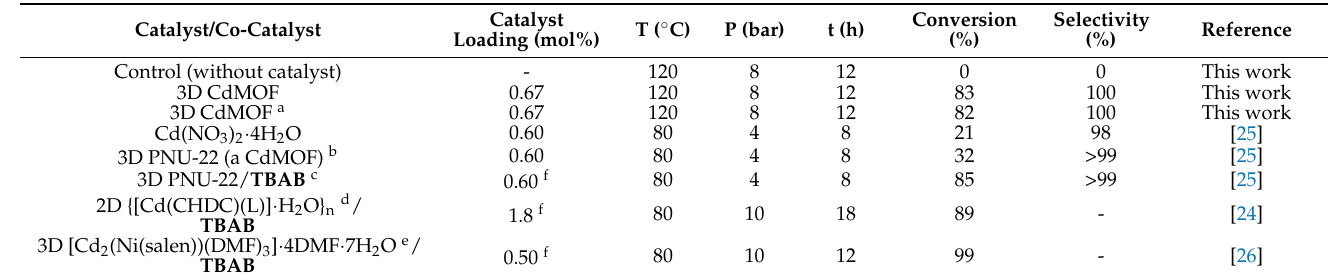
Table 1. Cycloaddition of CO 2 to epichlorohydrin catalyzed by CdMOF without cocatalyst and its a comparison with other CdMOFs.